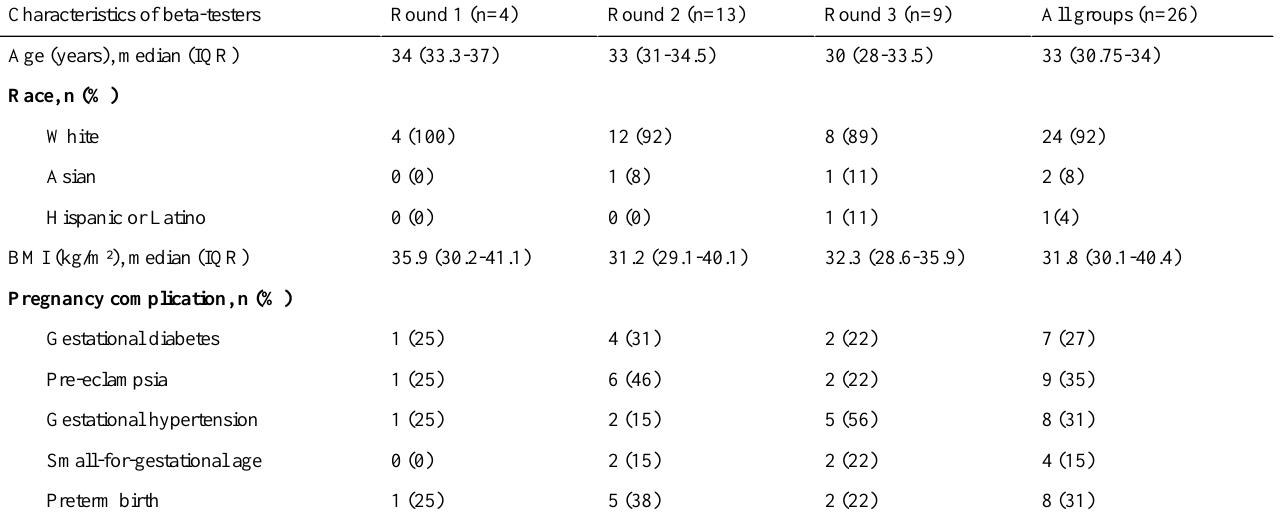
Table 1. Demographic data of participants in three rounds of beta-testing of the mobile health Fit After Baby program.